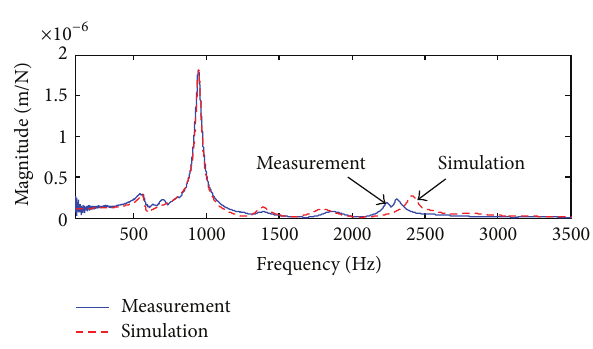
Figure 8: Comparison of the FRF at the tool tip between simulation and